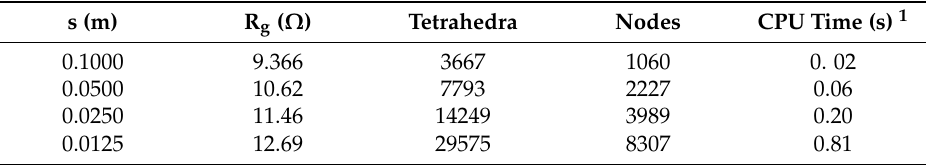
Table 1. Grounding resistance R g and computing effort in terms of CPU times and unknowns vs. different values of parameter s.